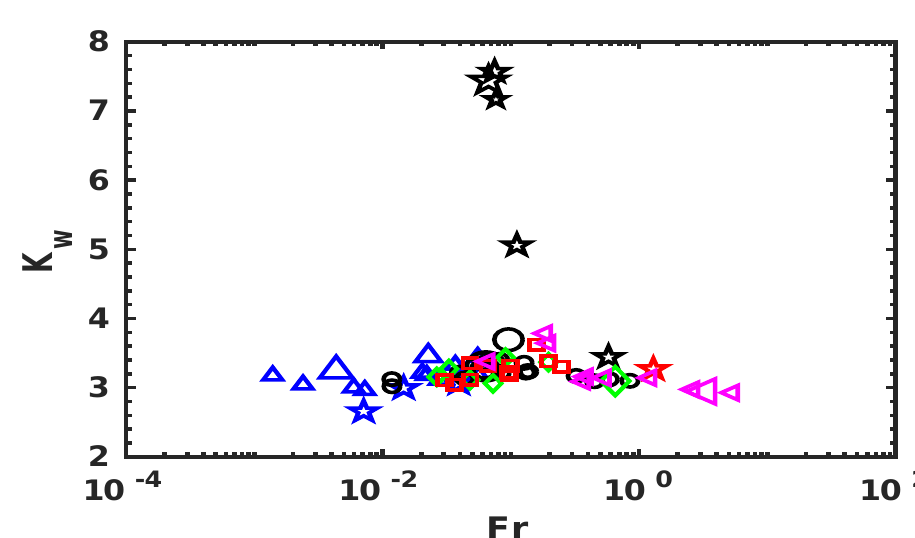
Figure 1. Kurtosis (see text for a definition), K W , of the vertical Eulerian velocity, w , as a function of Froude number, in log-lin coordinates with binning in Rossby number. Color/symbols indicate the following intervals: blue triangles for Ro circles (or stars) for [ 0.3,3 ) , black diamonds for [ 3,6 ) , red squares for [ 6,10 ) and inverted magenta triangles for [ 10, ∞ ) ; stars are for runs with QG initial